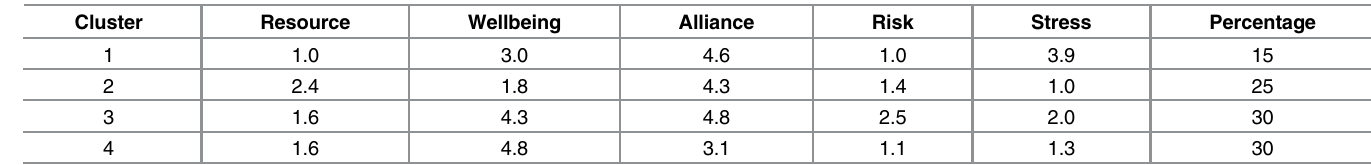
Table 3. Average weights of fitness criteria for clusters producing the layered pattern found in humans.